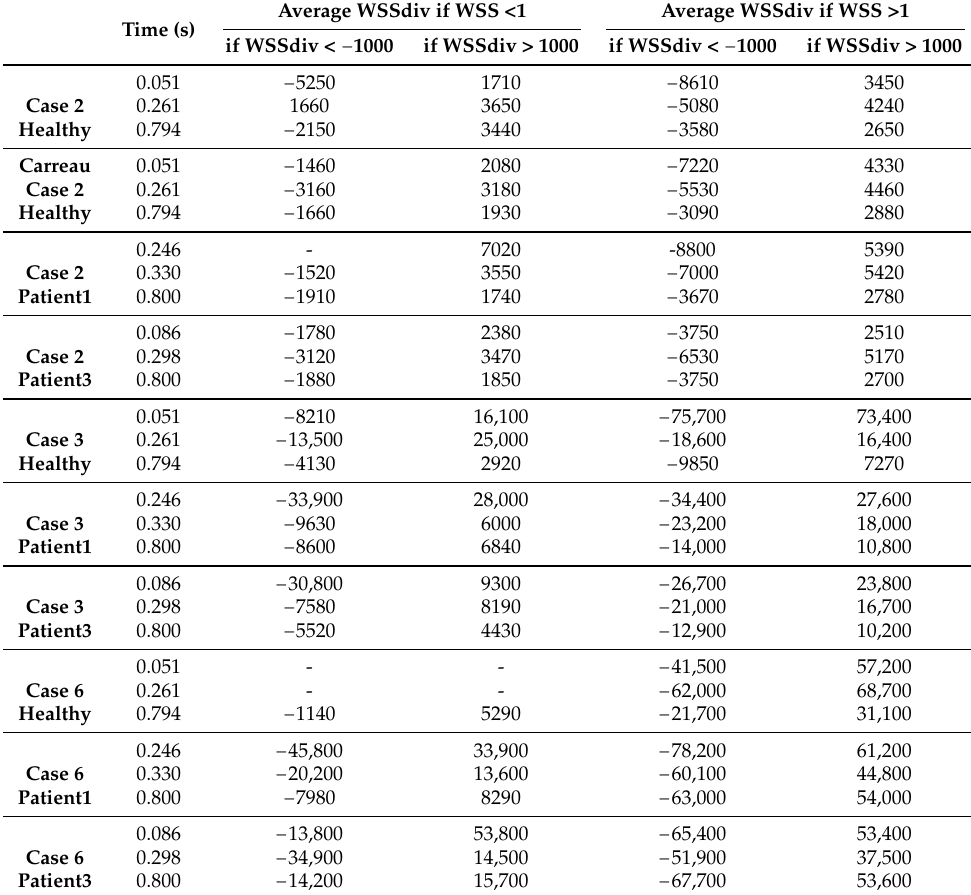
Table A3. Continuation of Table 4, for Case 2, Case 3 and Case 6 with flow rate profiles shown in Figure